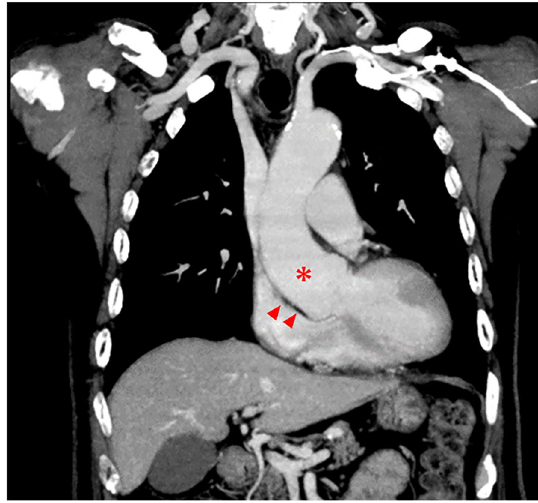
Fig. 1 Coronal computed tomography section of the heart. A remarkably enlarged aortic root (asterisk) compressed the right